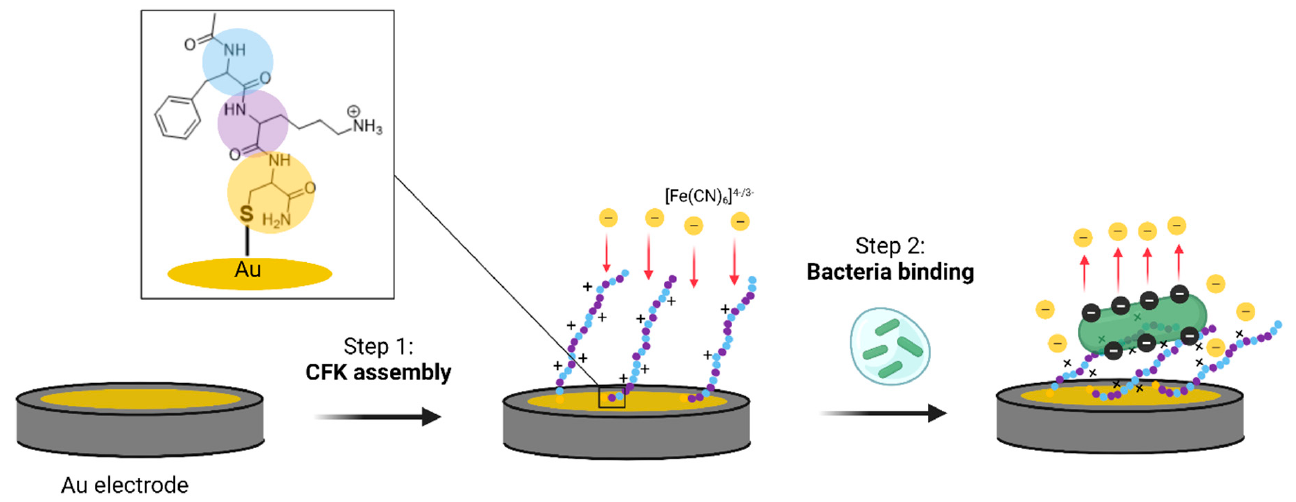
Figure 2. A graphical presentation of the study: CFK assembly on Au surfaces (step 1) and its rear- rangement after bacterial binding (step 2). The charge-transfer resistance (R CT ) increases in response to the bacteria adhesion due to its electrostatic repulsion of the redox active species [Fe(CN) 6 ] 3 − /4 − .